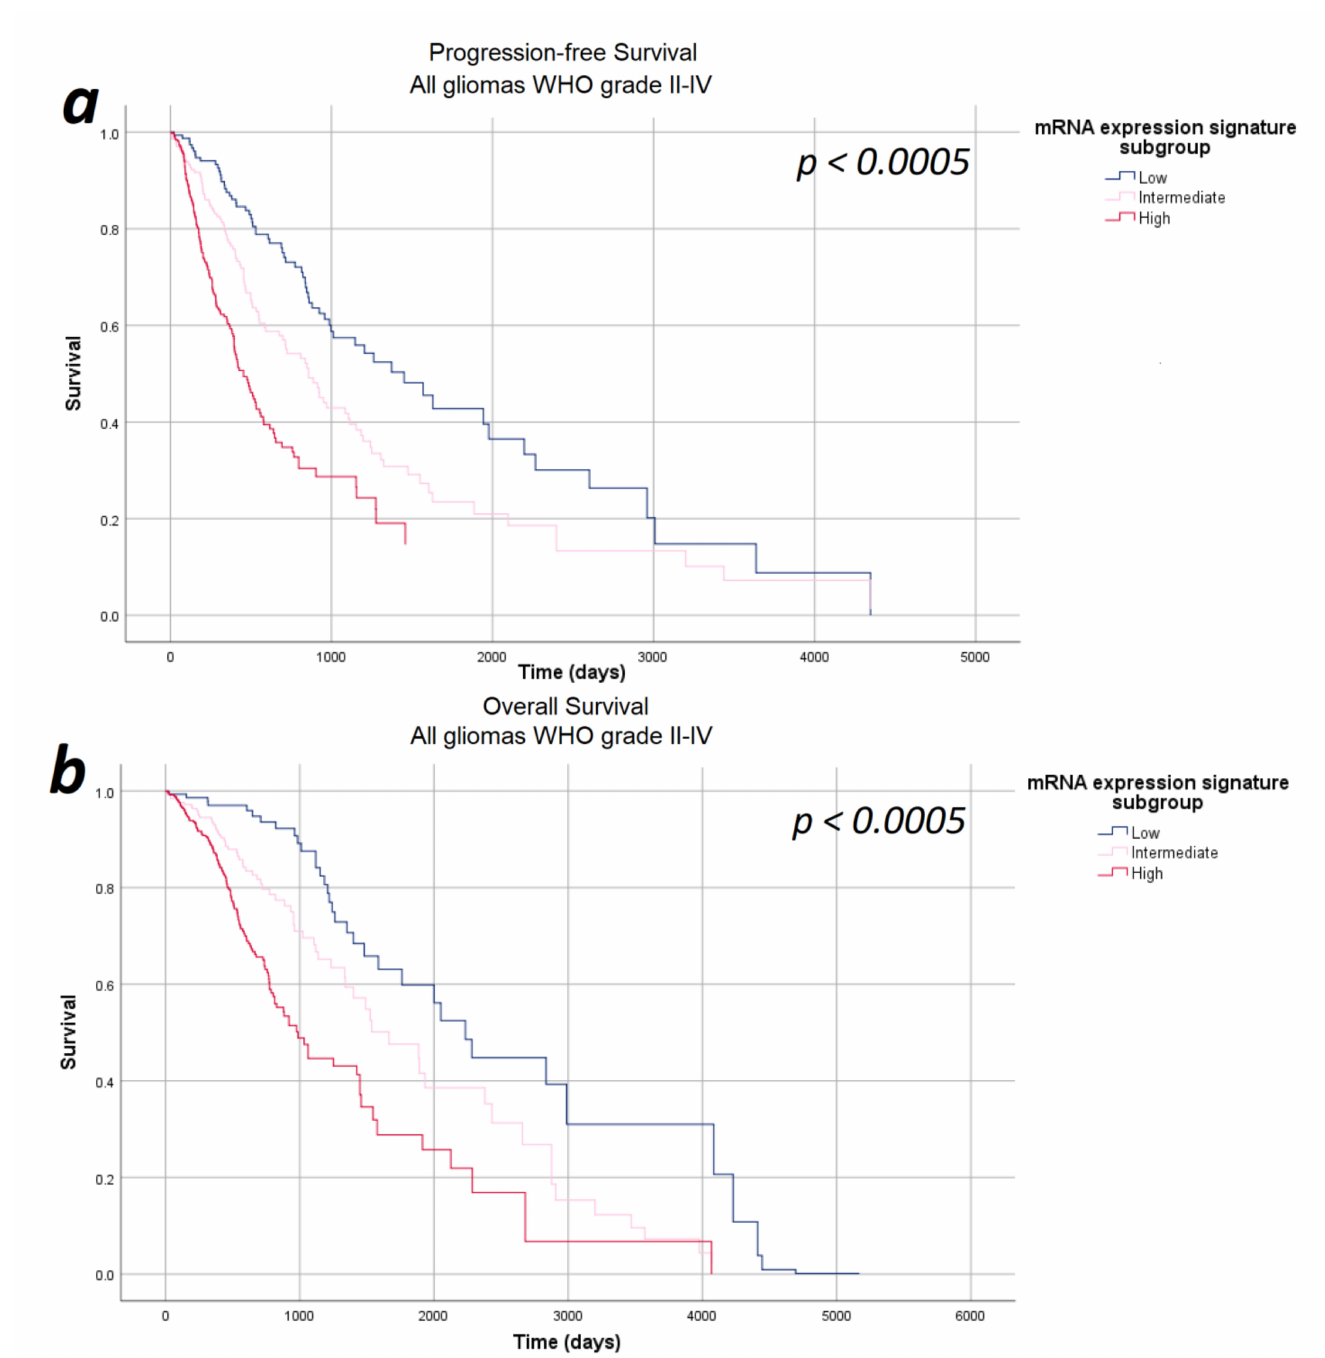
Figure 3. Survival-curves for progression-free survival and overall survival after correction for WHO tumor grade, tumor subtype, and patient age and sex as estimated by the multivariate analysis. ( a ) Progression-free survival and ( b ) overall survival: The mRNA expression signature significantly correlated with the progression-free survival as well as the overall survival after correcting for the WHO tumor grade, tumor subtype, and patient age and